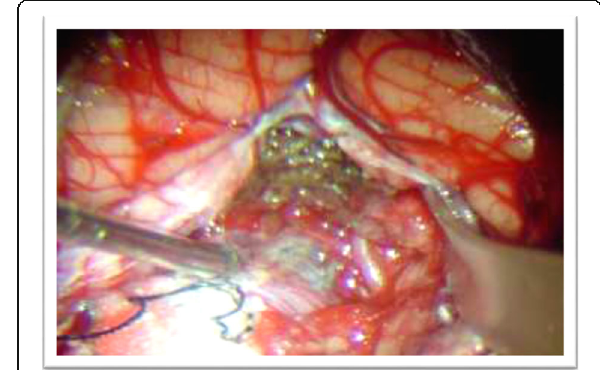
Fig. 3 Exposure of the fourth ventricle under microscope; the two cerebellar tonsils are retracted laterally to expose the floor of the fissure, i.e., inferior medullary velum and telachoroidea. The telachoroidea which forms the caudal part of the lower half of the roof of the fourth ventricle is incised from the foramen of the magendie and then followed laterally to the foramen of the luschka on both sides